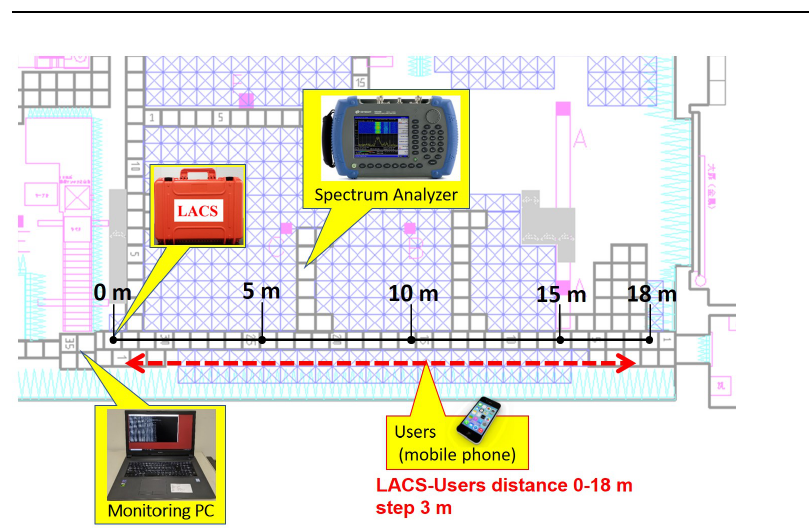
Figure 9. Experimental